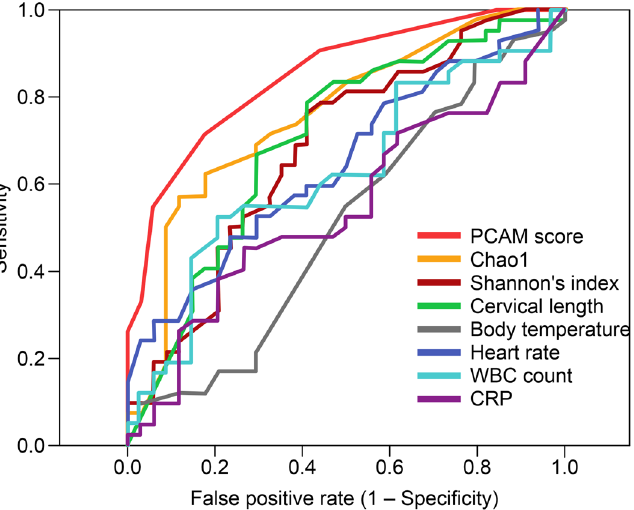
Figure 3. Predictive accuracy of PCAM scoring compared with the clinical data and α diversity indices. To compare the predictive diagnostic accuracy with the PCAM score and clinical indicators of body temperature, heart rate, white blood cell count, C-reactive protein value, cervical length, and α diversity index (Chao1, Shannon’s index), which comprised the common results of the 16S rDNA amplicon analysis, we calculated the AUCs using the ROC curve. The PCAM score was the most accurate measure, with an AUC of 0.849 (asymptotic 95% CI 0.765–0.934); sensitivity, 71.4%; and specificity, 82.4%. AUC area under the curve, PCAM predictive chorioamnionitis, ROC receiver operating characteristic.